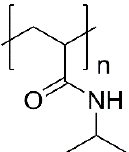
Figure 11. poly(N-isopropylacrylamide) (PNIPAM). Figure 11. Poly(N-isopropylacrylamide) (PNIPAM). The self-organization of ordered structures in a solution is enabled by the combi- nation of hydrophilic and hydrophobic monomers that are integrated into block copoly- mers, the most common of which are micelles. Micelles are helpful for encapsulating and delivering hydrophobic medicines into an aqueous environment. Well-studied thermo- responsive polymers that are capable of forming micelles are poly(ethylene glycol) (PEG) and poly(propylene glycol) (PPG) (Figure